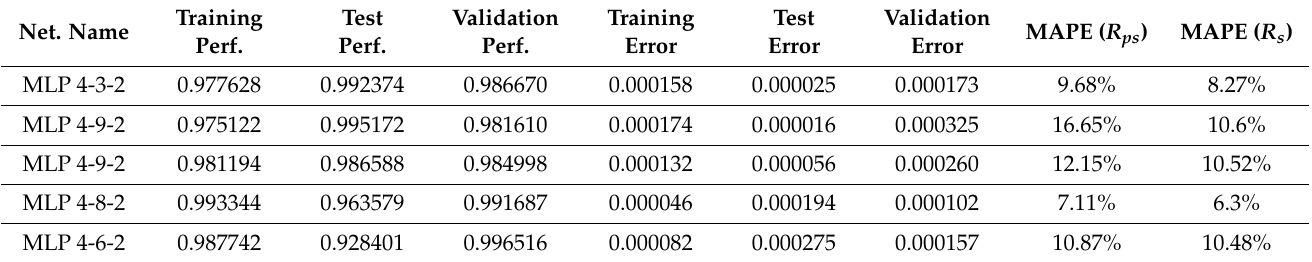
Table 11. Alternative multivariate models for predicting the profitability of an enterprise.